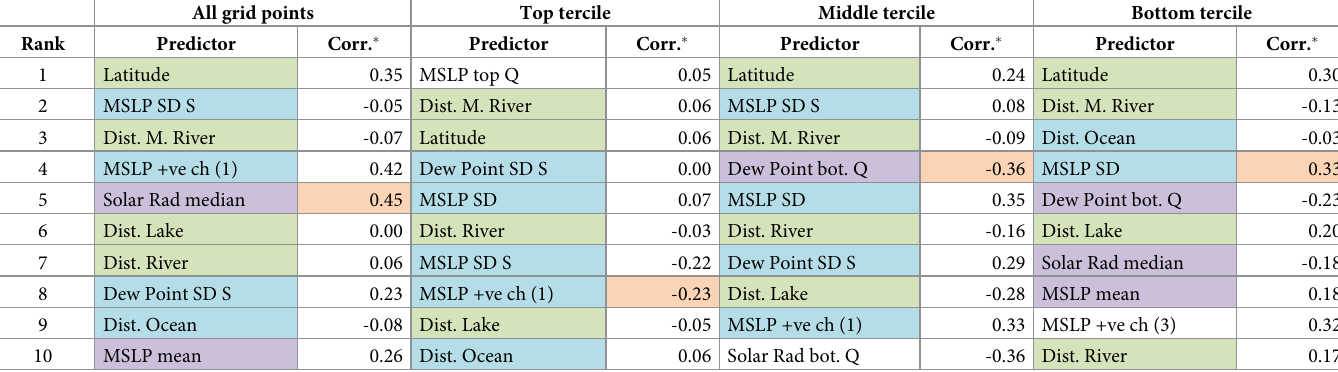
Table 4. Top 10 predictors and ( � ) their one-to-one linear correlation coefficient with GCP-PC for the cases of all-grid-point, top tercile, middle tercile, and bottom tercile. Green cells indicate predictors in common with the four cases, light blue in common with three cases and purple in common with two cases. Highlighted in salmon are the largest one-to-one correlation values for each of the four cases.